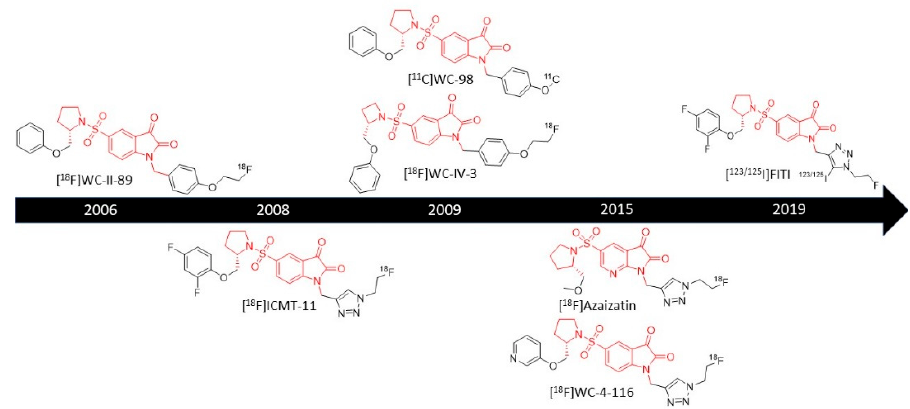
Figure 3. Timeline of the development of the main isatin sulfonamide radiotracers. The core isatin sulfonamide structure is represented in red.